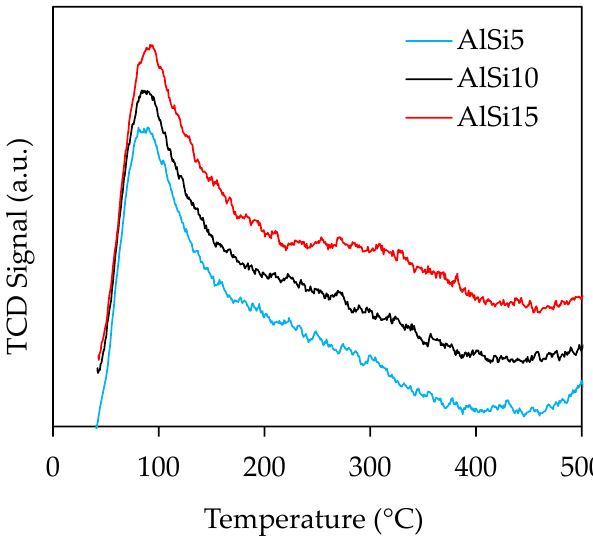
Figure 3. NH 3 -TPD results for powder samples AlSi5, AlSi10 and AlSi15.